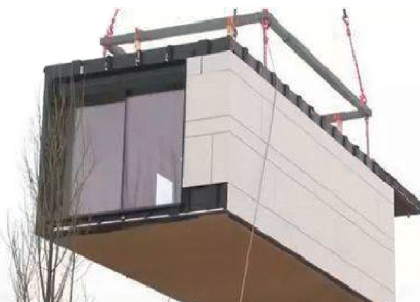
Figure 2: Hoisting and installation of a modular prefabricated building prototype (source: authors’ own data).